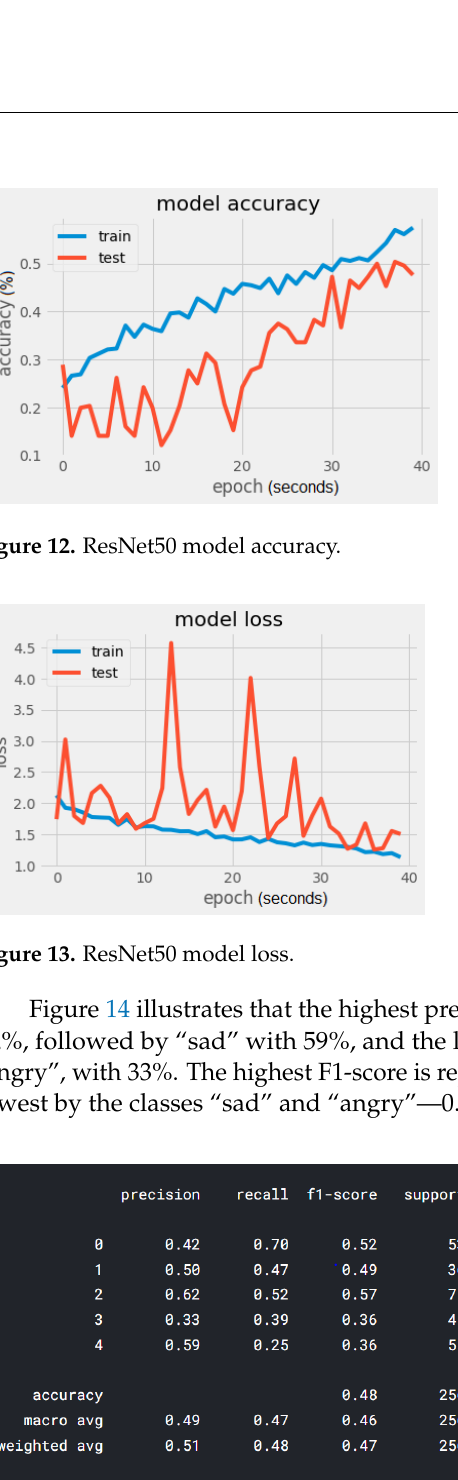
Figure 14. ResNet50 classification report.